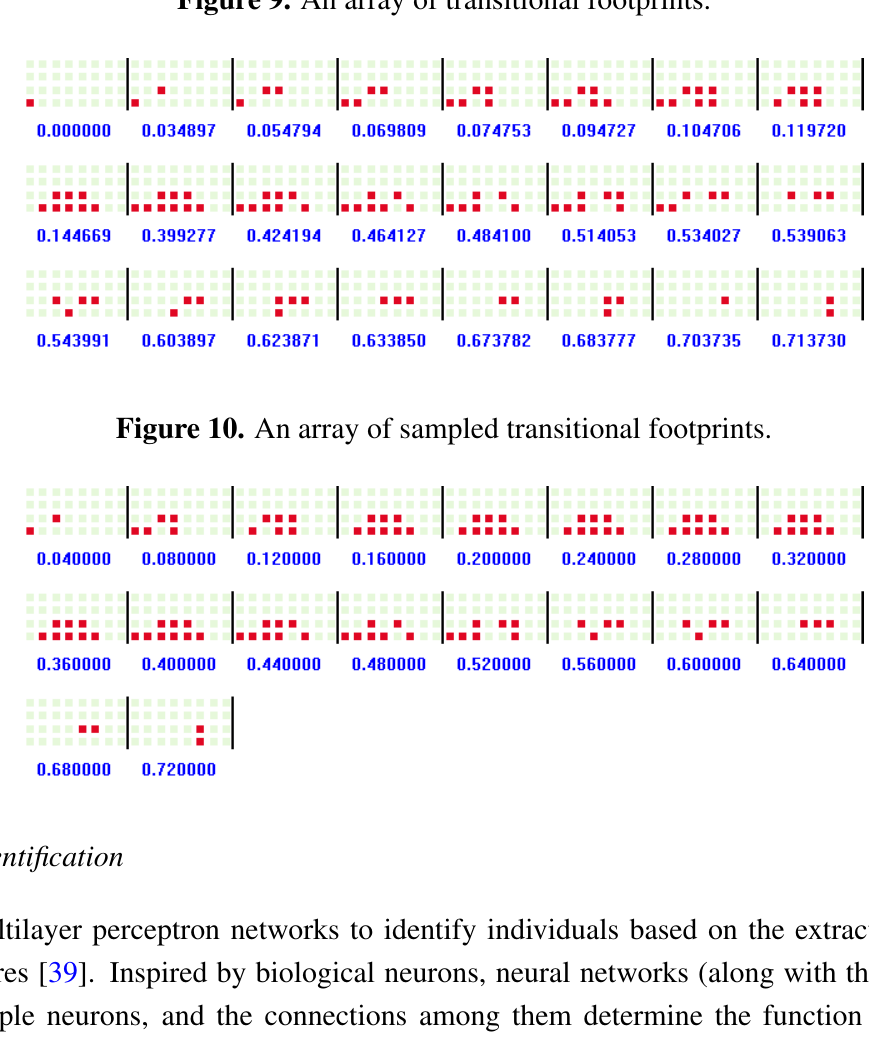
Figure 9. An array of transitional footprints.